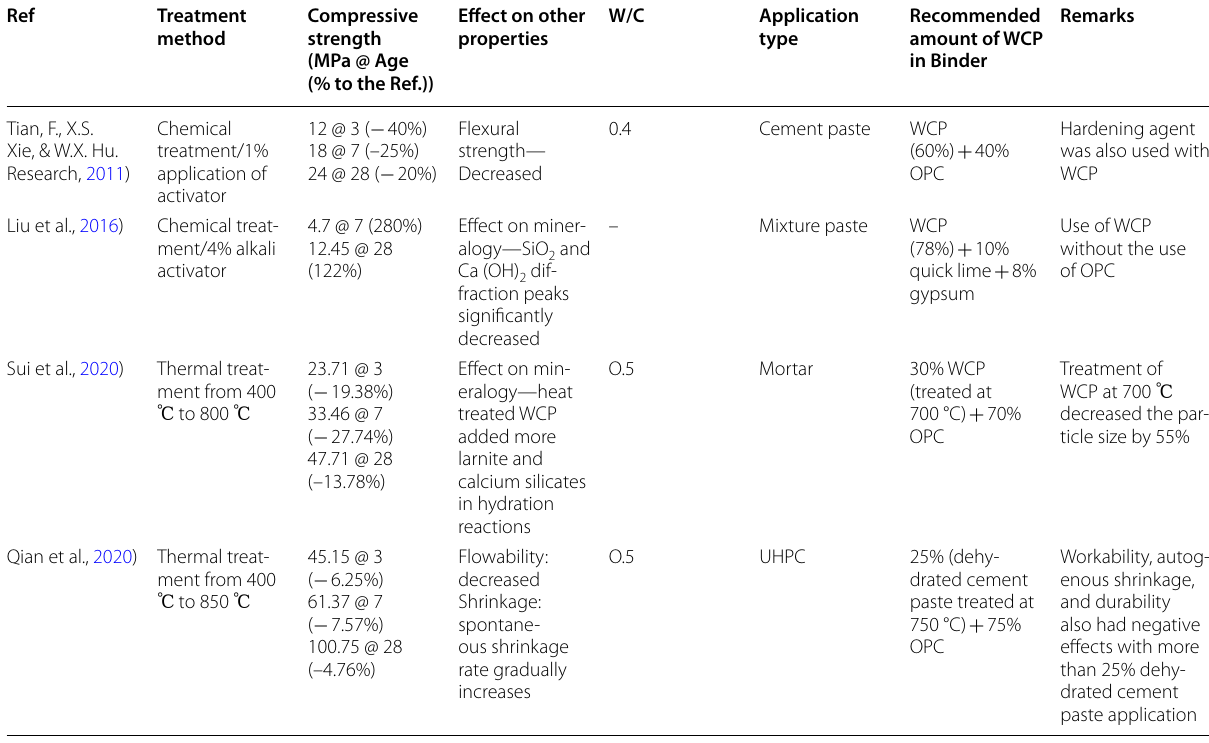
Table 2 Effect of treated WCP on compressive